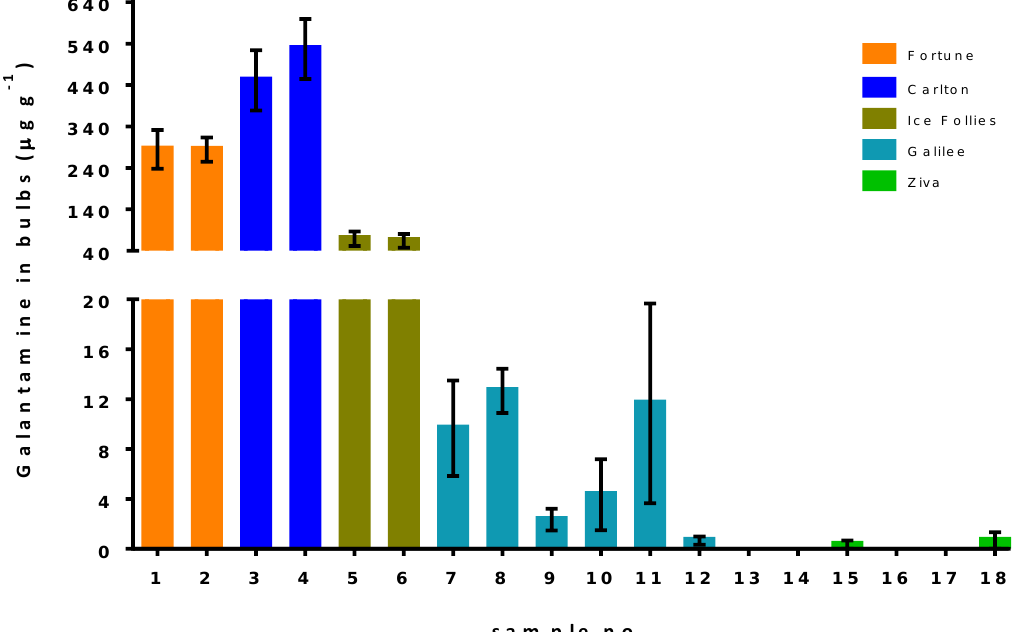
Figure 2. Galantamine concentration in the bulbs of different Narcissus cultivars, under different irrigation and pruning levels. Five Narcissus cultivars were grown under different irrigation and pruning levels. Sample numbers 1, 3 and 5 represent normal irrigation and samples 2, 4 and 6 represent reduced irrigation. Samples 7, 8 and 9 represent normal irrigation and no pruning, high pruning and low pruning, respectively, with the same conditions for samples 13, 14 and 15. Samples 10, 11 and 12 represent reduced irrigation and no pruning, high pruning and low pruning, respectively, with the same conditions for samples 16, 17 and 18 (see Table 2). The galantamine concentration in the bulbs was quantified using LC–MS/MS. Results are means ± standard error ( n = 3).